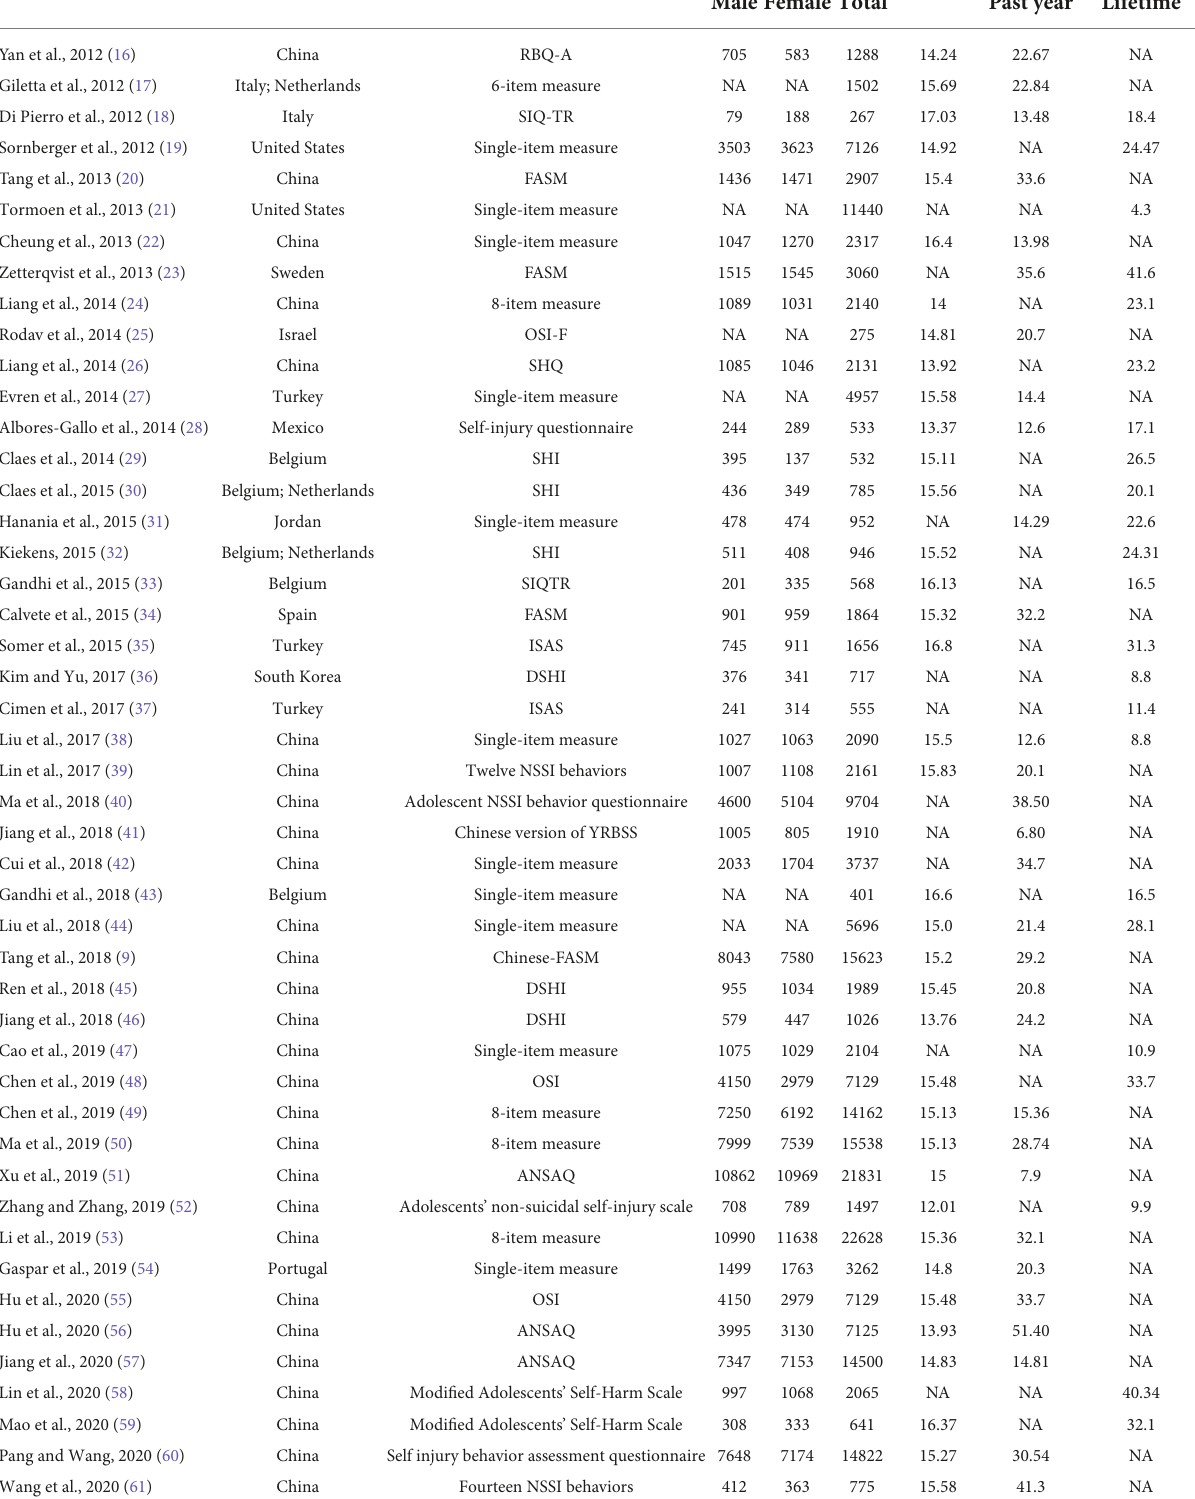
TABLE 1 Characteristics of the included